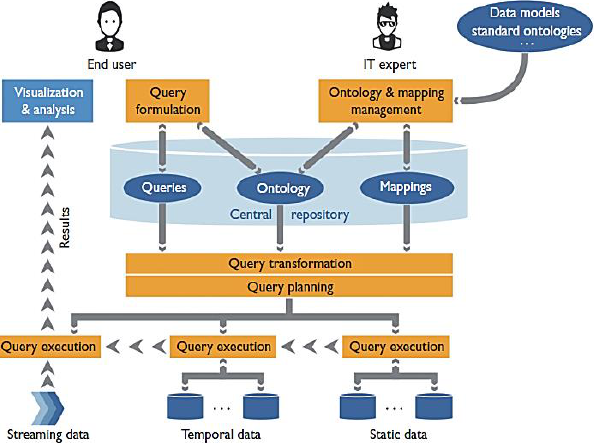
Figure 5. Optique platform